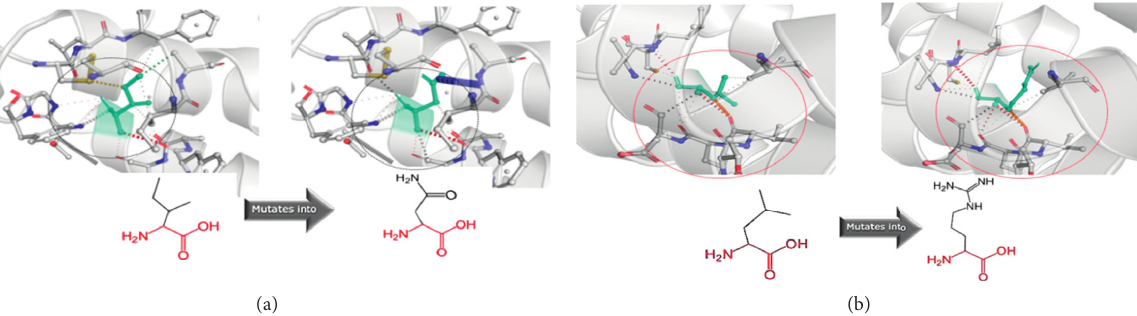
Figure 2: (a) Substitution of p.Ile84Asn in the MC2R gene: the left panel is the wild type, and the right panel is mutant asparagine. The interaction of the amino acids was changed in the substitutions. (b) Substitution of p.Leu43Arg in the MC2R gene and amino acid in- teraction change. Characterization of the reported MC2R and MRAP